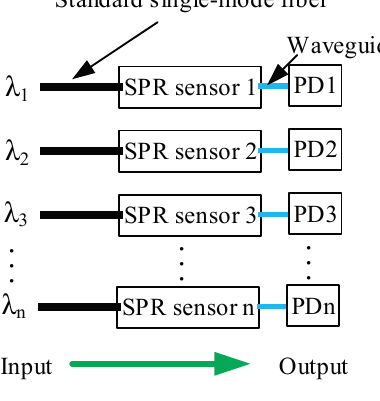
Figure 12. Schematic of SPR sensor array for wavelength interrogation.